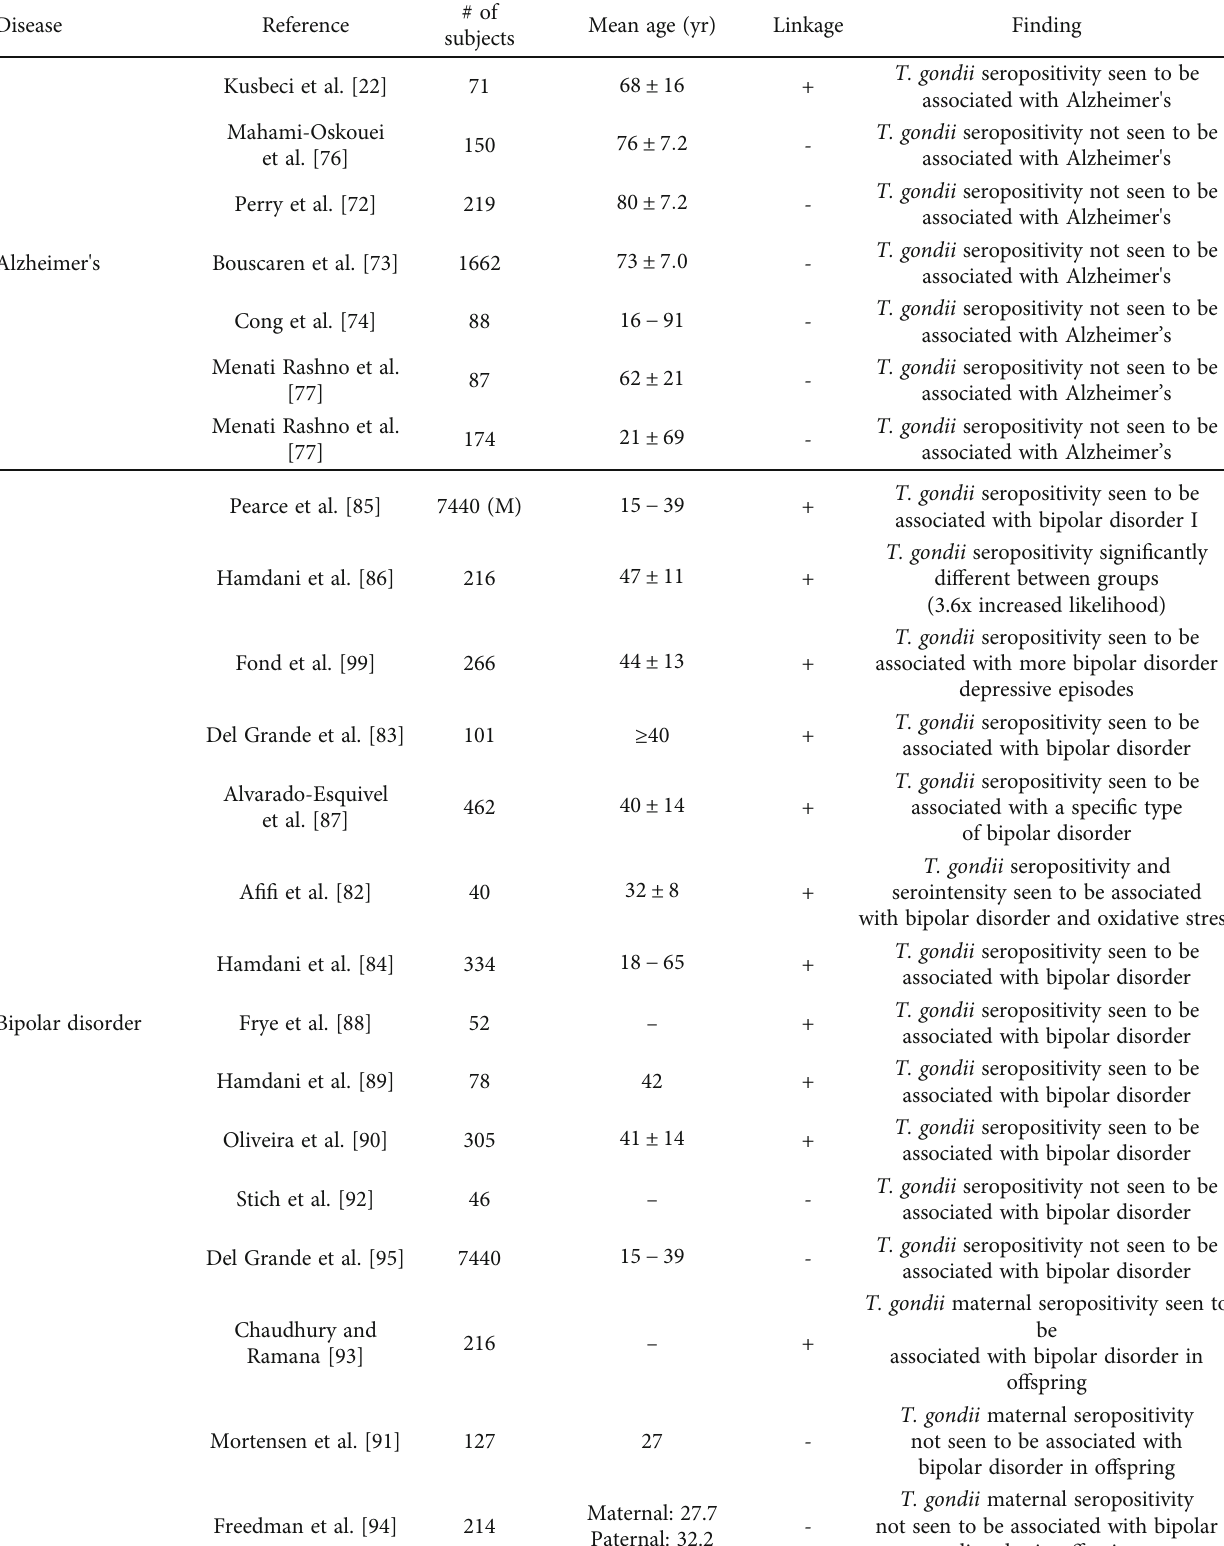
Table 1: Studies conducted examining possible linkages of T. gondii infection with neurobehavioral symptoms and disorders.